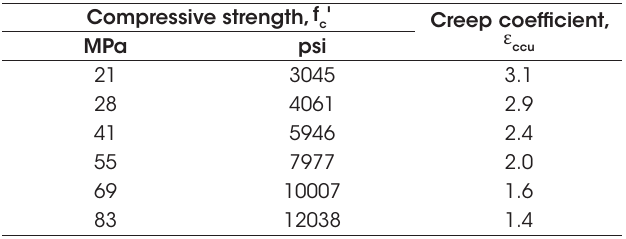
λ = proposed long-term deflection multiplier, dimensionless. prop r ' = compressive reinforcement ratio. Typical creep parameters (from [26])